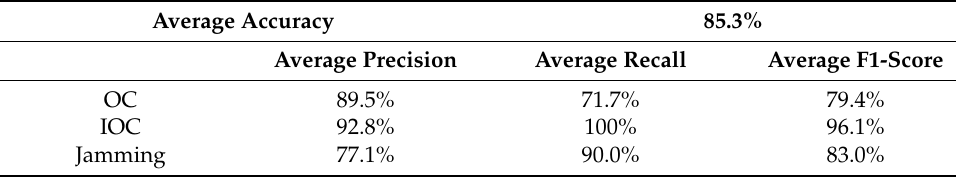
Figure 8. Confusion Matrix for TSF Univariate Model. Table 8. TSF Univariate Performance. Average Accuracy